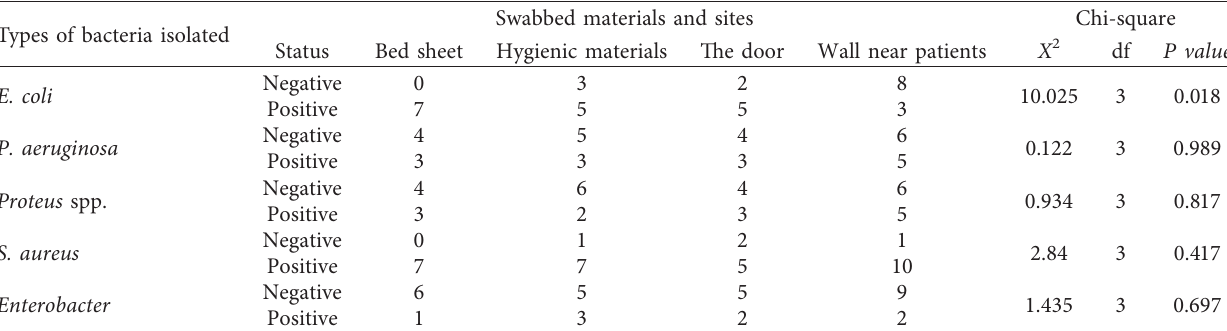
Table 5: Bacteria isolates and their association with swabbed materials and wound